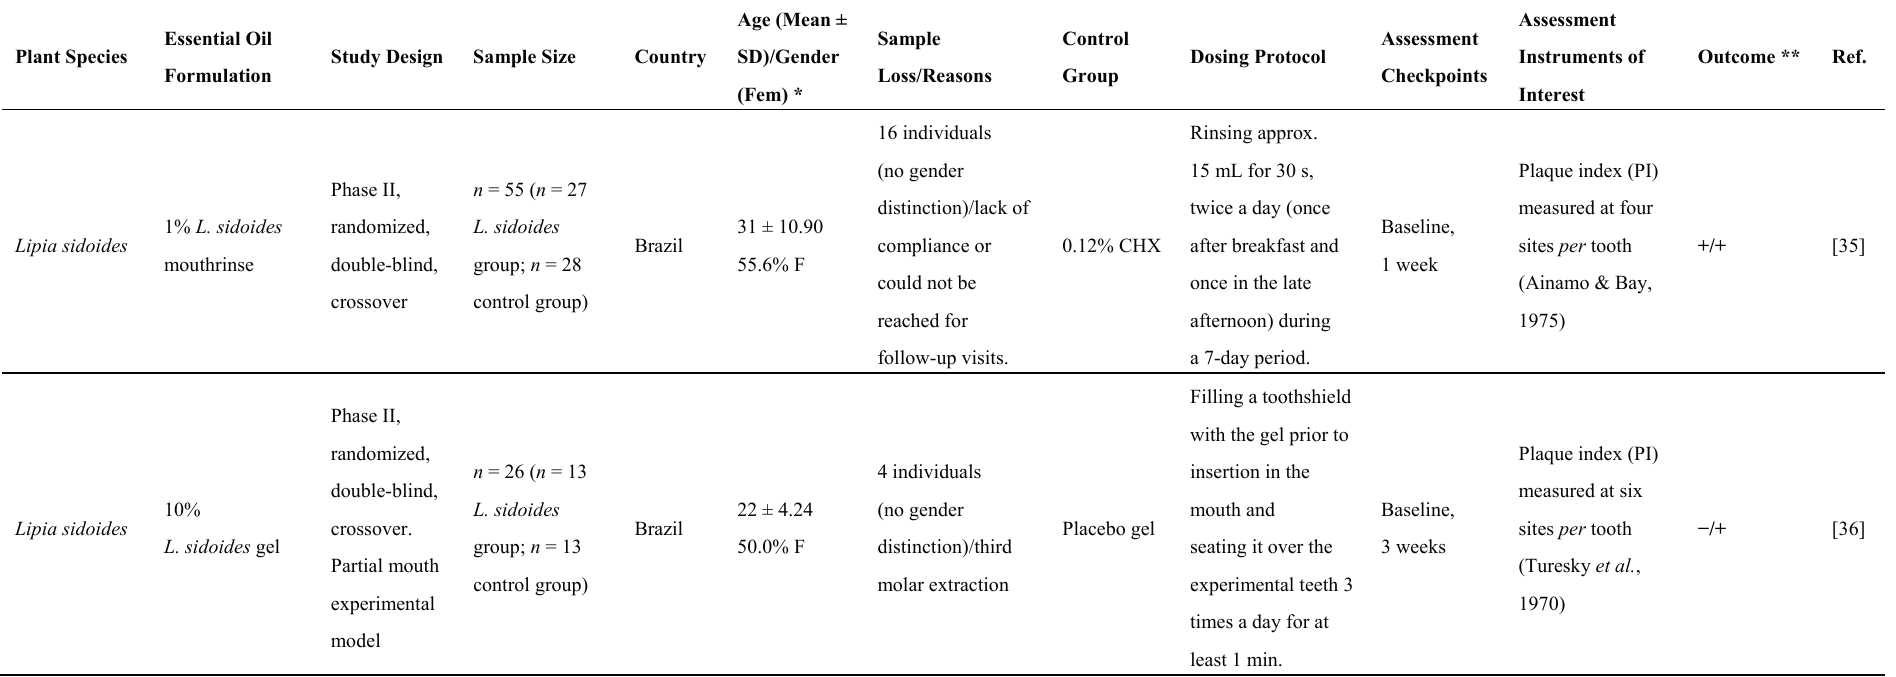
Table 9. Characteristics of the Randomized Clinical Trials included in this systematic